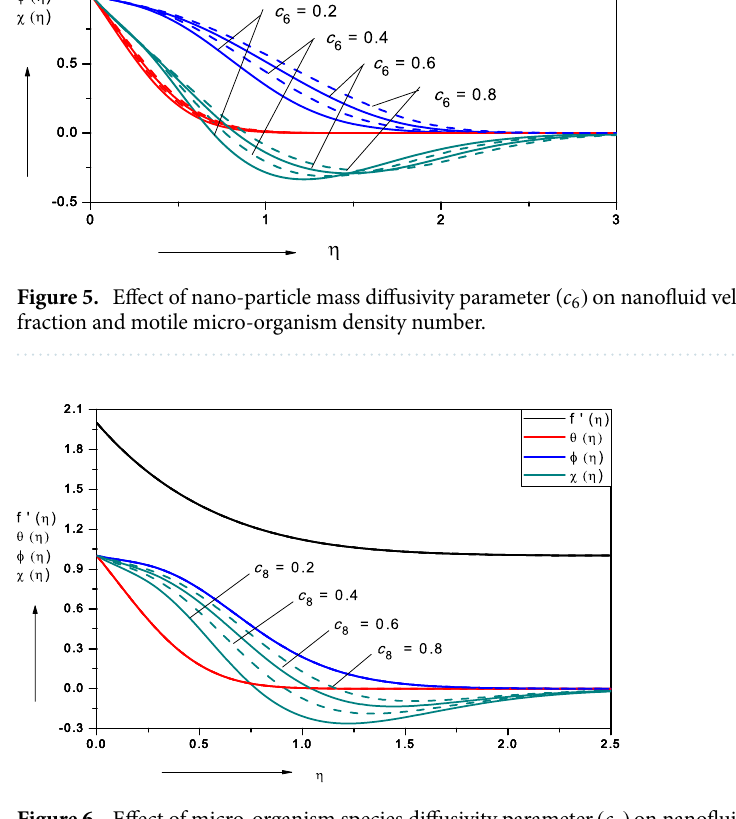
Figure 6. Effect of micro-organism species diffusivity parameter ( c 8 ) on nanofluid velocity, temperature, volume fraction and motile micro-organism density number.